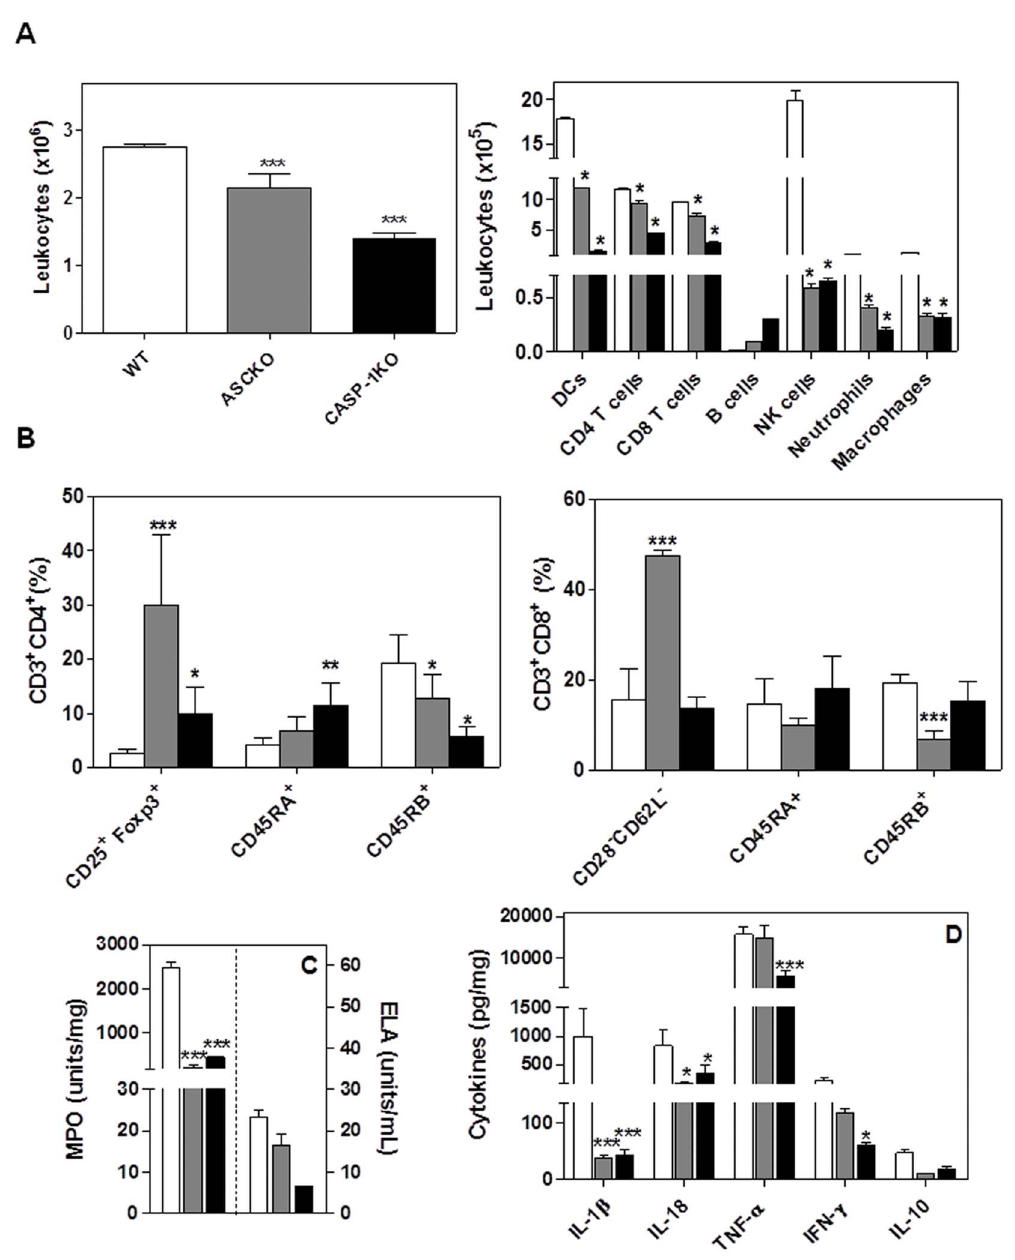
Figure 2. Characterization of SCC lesions in the absence of inflammasome after 12 weeks. (A) The absolute number and phenotype of leukocytes in the tumor lesions were determined by flow cytometry. (B) Flow cytometry analyses of CD25 + Foxp3 + , CD45RA + , CD45RB + and CD28 2 CD62L 2 expression on CD4 e CD8 T cells. (C) Myeloperoxidase (MPO) and elastase (ELA) activity in tumor microenvironment. (D) Cytokines profile in tumor microenvironment at 12 weeks after SCC induction. Values are mean 6 SEM; * p # 0.05, *** p # 0.001 compared with WT mice. doi:10.1371/journal.pone.0107170.g002 PLOS ONE |